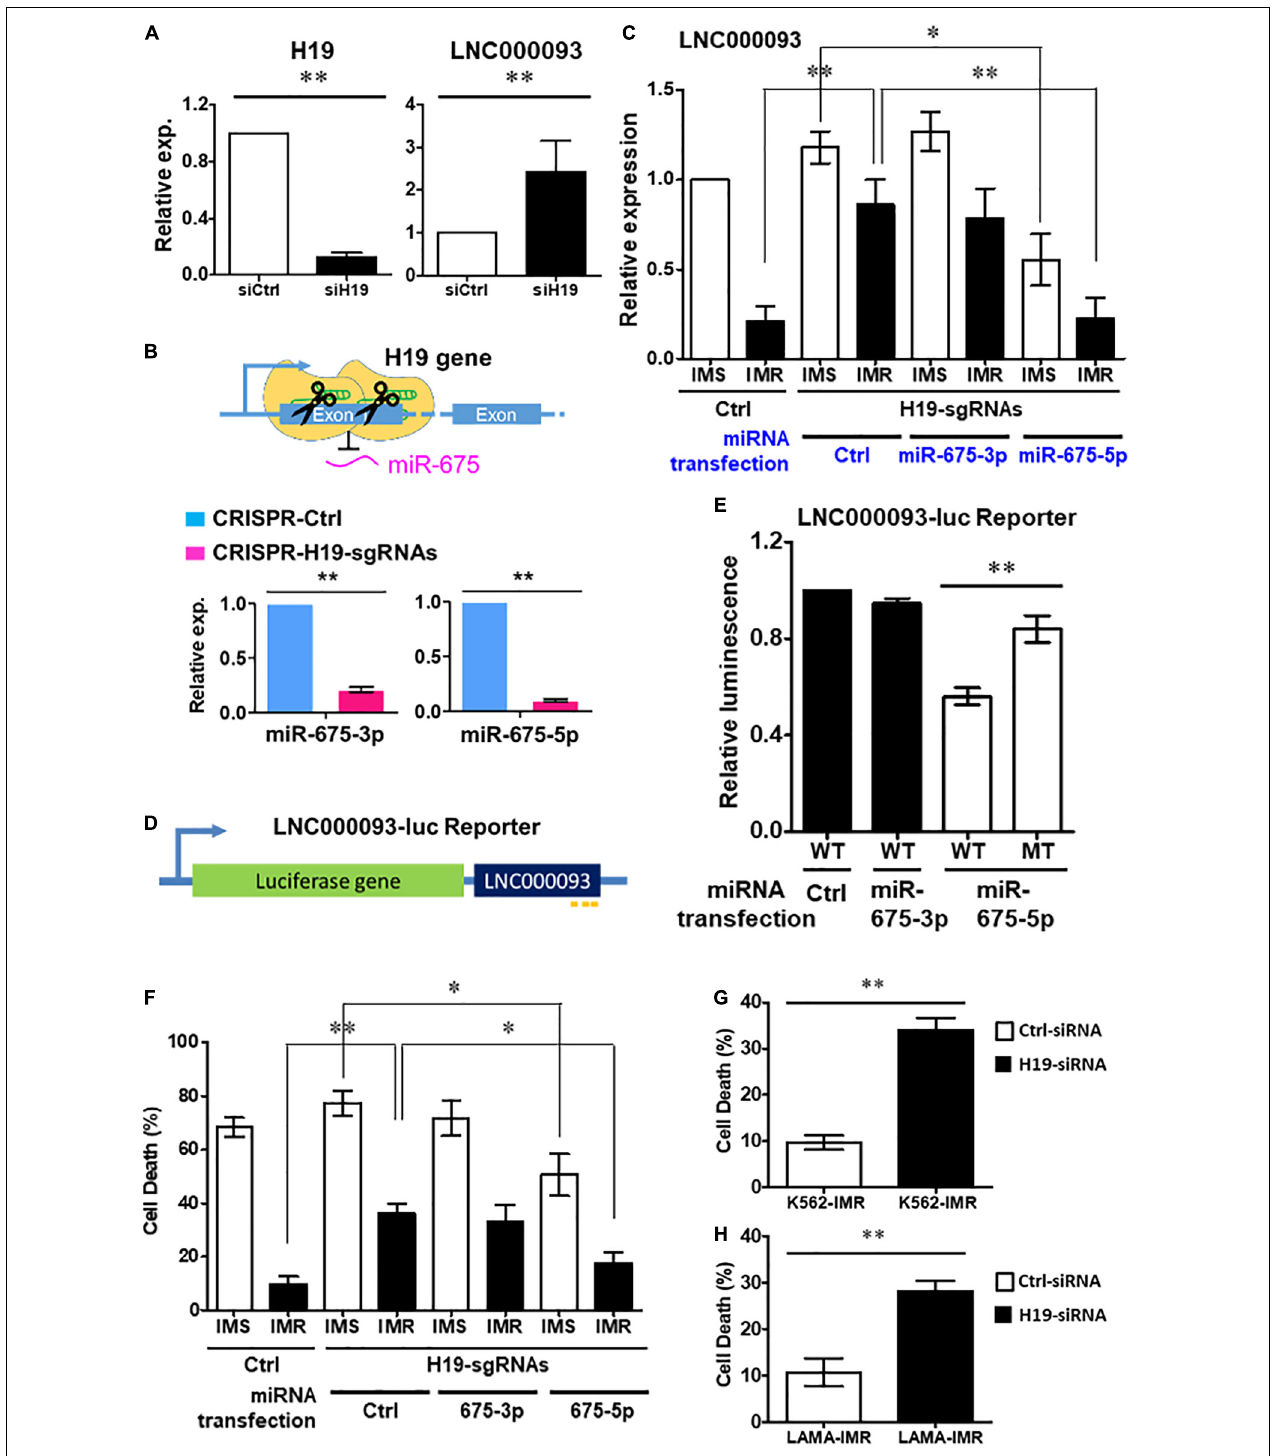
FIGURE 3 | Regulation of LNC000093 expression by H19/miR-675-5p via direct binding sequence. (A) An increased expression of LNC000093 was detected in K562 cells transfected with H19-siRNA ( n = 3). The mean ± SD is shown for the results. ∗∗ P < 0.01. (B) After CRISPR-Cas9-mediated deletion of H19/miR-675, both miR-675-3p and − 5p showed significant downregulation as shown by RT-qPCR analysis ( n = 3). The mean ± SD is shown for the results. ∗∗ P < 0.01. (C) RT-qPCR analysis revealed an enhanced LNC000093 expression in H19/miR-675-deleted K562-IMR cells. Overexpression of miR-675-5p via microRNA transfection reversed the upregulation of LNC000093 in H19/miR-675-deleted K562-IMR and induced a downregulation of LNC000093 in H19/miR-675-deleted K562-IMS ( n = 3). The mean ± SD is shown for the results. ∗ P < 0.05, ∗∗ P < 0.01. (D) A luciferase reporter vector was constructed with insertion of the